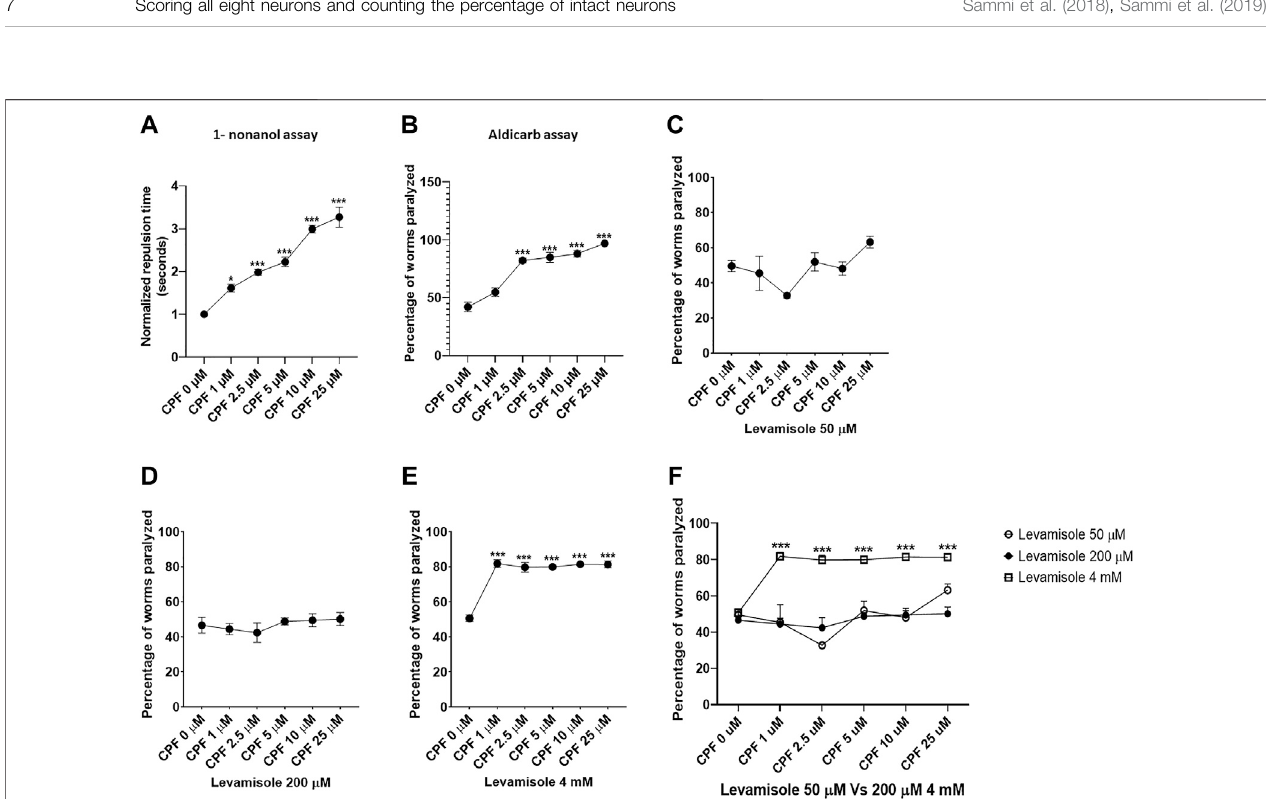
FIGURE3| Behaviorassaysforevaluationofdopaminelevels,Acetylcholinelevelsandnicotinicacetylcholinereceptoractivity. (A) 1-nonanolassay:CPFtreatment exhibited increased repulsion time in a dose-dependent manner which corresponds to the lowered levels of dopamine. (B) Aldicarb assay: CPF treatment led to an increase in the percentage of worms paralyzed, indicating augmented levels of acetylcholine in a concentration-dependent manner. (C) Levamisole assay: CPF treatment exhibited no effect on nAchR activity at Levamisole concentration 50 µM. (D) Levamisole assay: CPF treatment exhibited no effect on nAchR activity at Levamisole concentration 200 µM. (E) Levamisole assay: CPF treatment exhibited signi fi cant increase in nAchR activity at above optimum Levamisole concentration 4 mM resulting in false positive results due to saturation effect. (F) Comparison of the effect of Levamisole across three different concentrations All experiments were conducted in three independent replicates. For 1-nonanol assay a minimum of 20 worms were analyzed per replicate, whereas 20 to 30 worms were analyzed for Aldicarb assay and Levamisole assay. Data were analyzed using one-way ANOVA followed by Dunnett ’ s post hoc test. * p < 0.05, ** p < 0.005, and *** p < 0.001 ( n = 3).